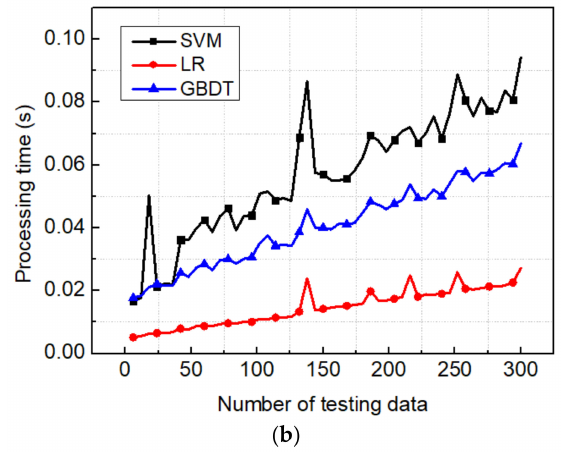
Figure 16. Processing time for different algorithms trained on ( a ) S 11 , ( b ) S 21